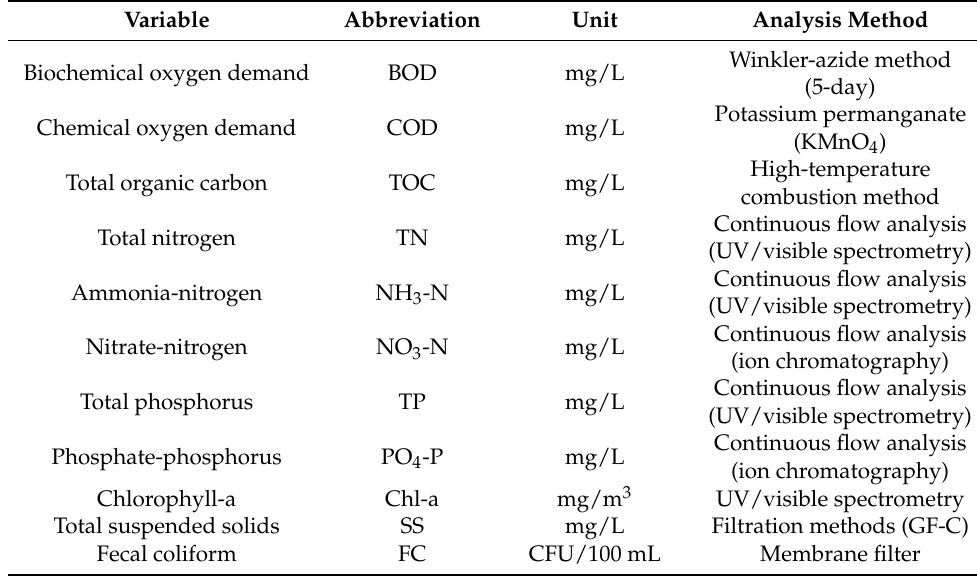
Table 1. Unit and analysis method of water quality